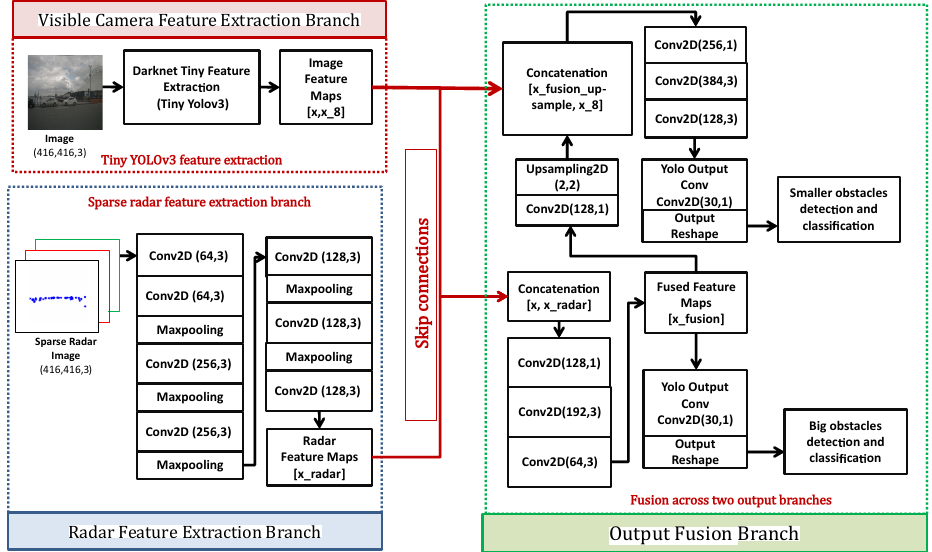
Figure 4. An overview of the RVNet